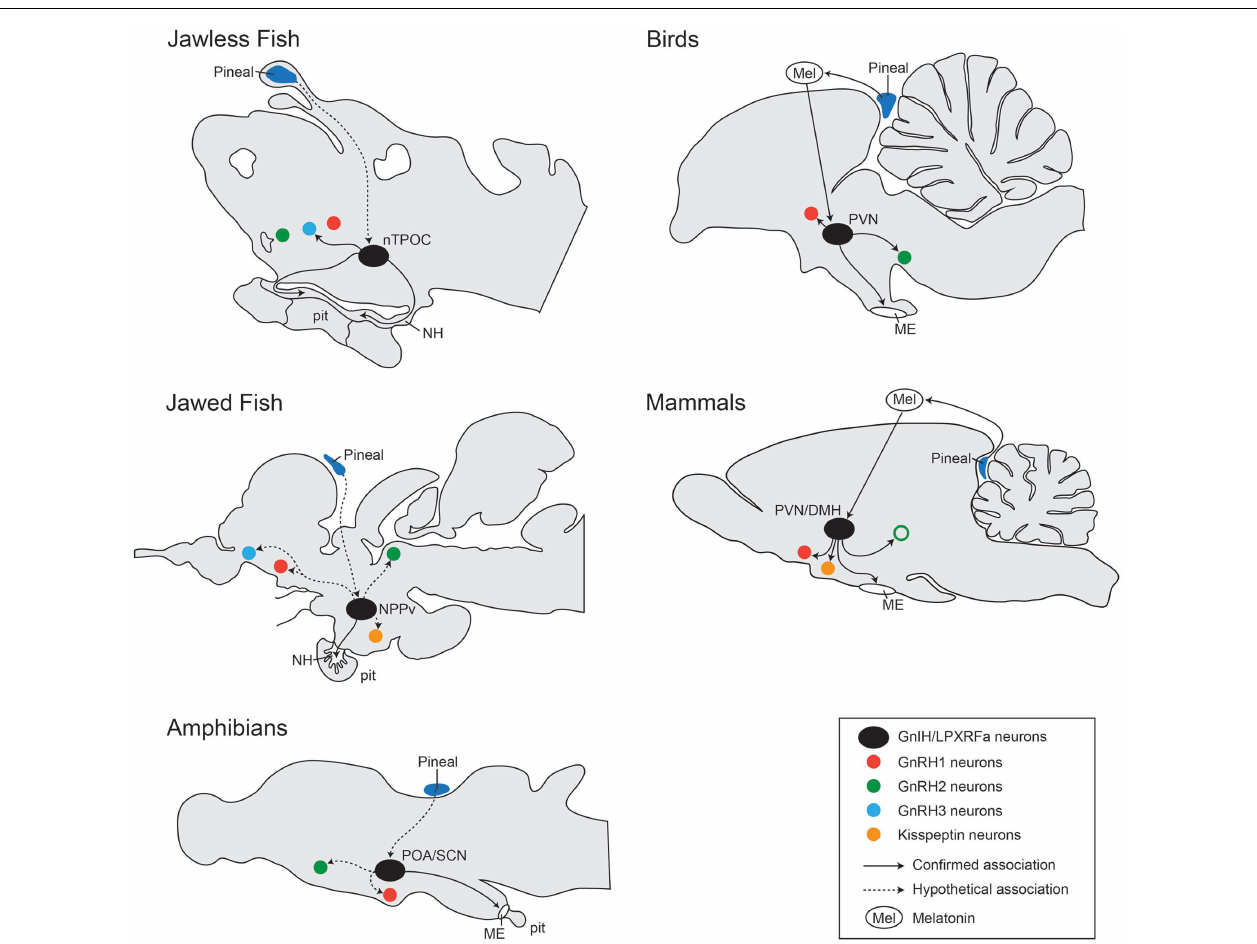
pituitary (pit) cells. In jawed fish, LPXRFa-immunoreactive fibers are present in the pituitary. In amphibians, birds, and mammals, LPXRFa/GnIH fibers are terminated in the ME. In birds and mammals, GnIH cells ( black circle ) associated with several other neurons such as GnRH neuron types: GnRH1 ( red circle ), GnRH2 ( green circle ), and GnRH3 ( blue circle ) neurons.The open circle with green indicates the presence of GnRH2 neurons only in certain mammalian species such as primates but not in rodents (73). In some mammals, GnIH fibers are also closely associated with kisspeptin neurons ( yellow circle ). GnIH neural functions are regulated by melatonin (Mel) derived from the pineal gland (dark blue) or eyes. In jawed and jawless fish, the effect of melatonin on GnIH neurons is still unknown, but there might be direct projection from the pineal gland to GnIH neurons in the hypothalamus (74–76). Confirmed association is indicated by the line, and unconfirmed hypothetical association is indicated by the dotted